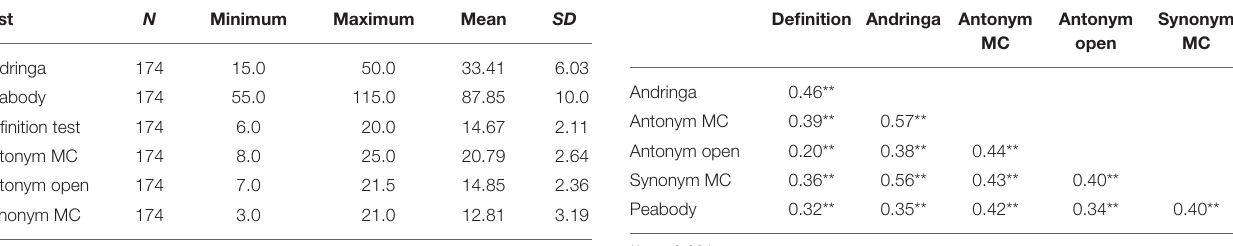
TABLE 6 | Correlations between the different vocabulary scores for the group of vocational college students.